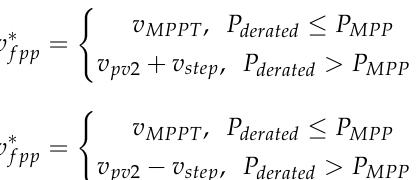
Figure 3. The PV operating point characteristic for FPPT.